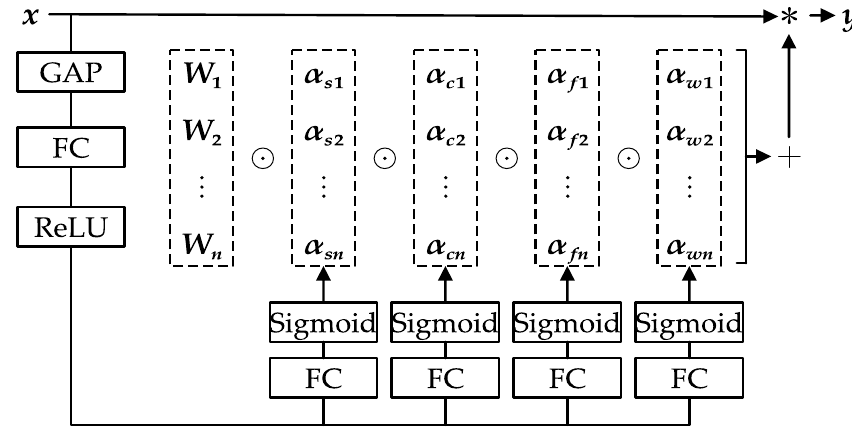
Figure 2. A schematic of ODConv uses GAP + FC + Sigmoid.